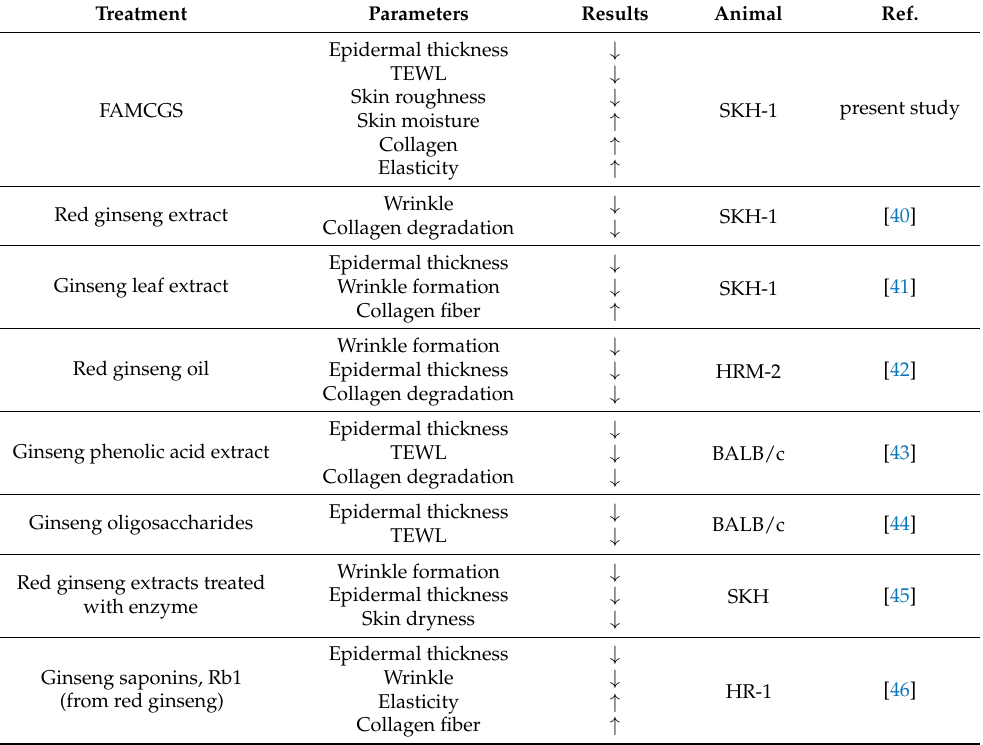
Table 1. Anti-aging effect of ginseng-derived products on UVB-induced photoaging in hairless